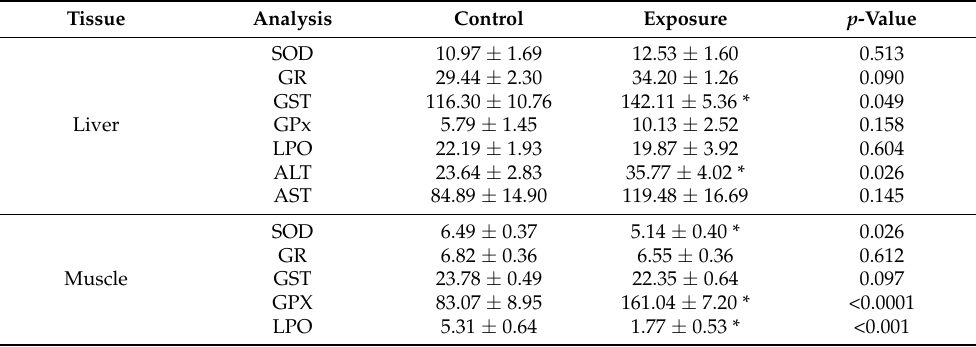
Table 3. Antioxidant system and tissue damage. Results expressed in mean ± standard error. * denotes a significant difference from the control ( p < 005). £ denotes the use of the Mann–Whitney U test.